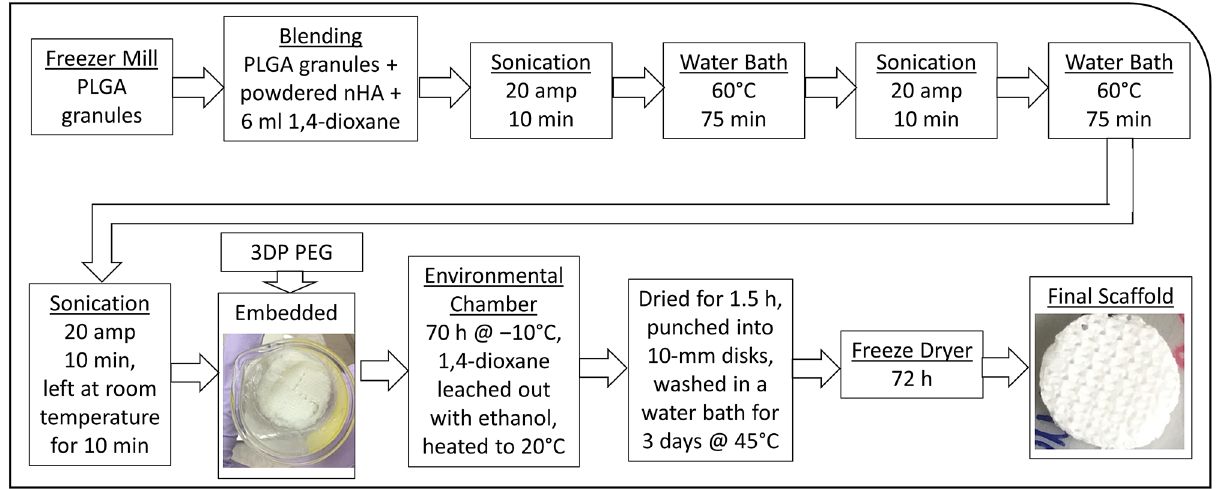
Fig. 1 The scaffold fabrication process utilizing the 3DP/TIPS